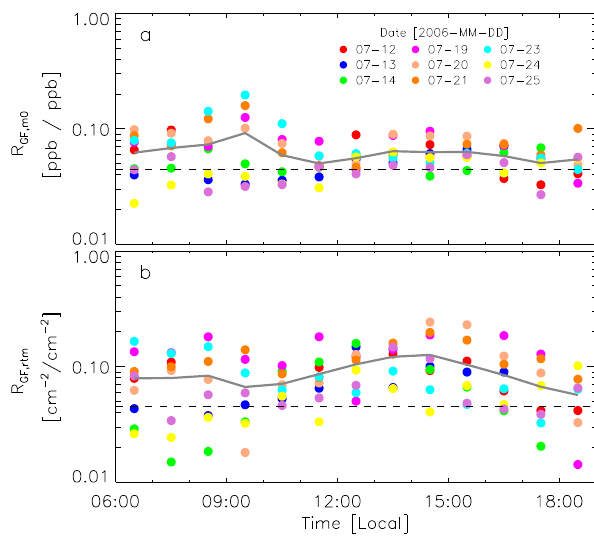
Fig. 11. Diurnal variation of CHOCHO/HCHO ratio ( R GF ) on the 9 cloud-free days during the PRIDE-PRD2006 campaign. The dots are values calculated from individually measured m 0 (pannel a ) and VCD rtm (pannel b ). Solid lines refer to the average values of the individual